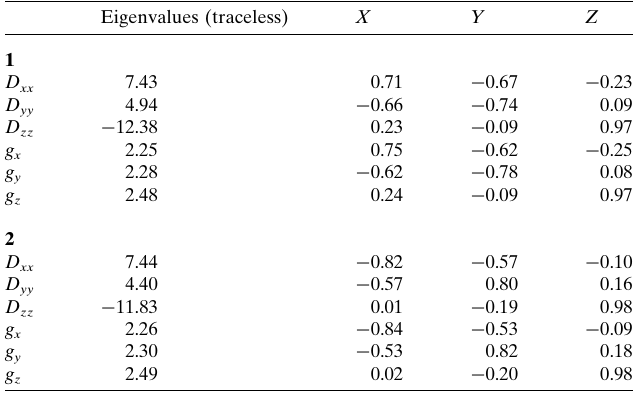
Table 3 Eigenvalues of the calculated D - and g -tensors for 1 and 2 . Elements of D are given in cm (cid:2) 1 and g is unitless. Note that we use here the criterion j D j (cid:3) 3 E (cid:3) 0 in contrast to the definition 1/3 (cid:3) E / D (cid:3) 0 used in ORCA .